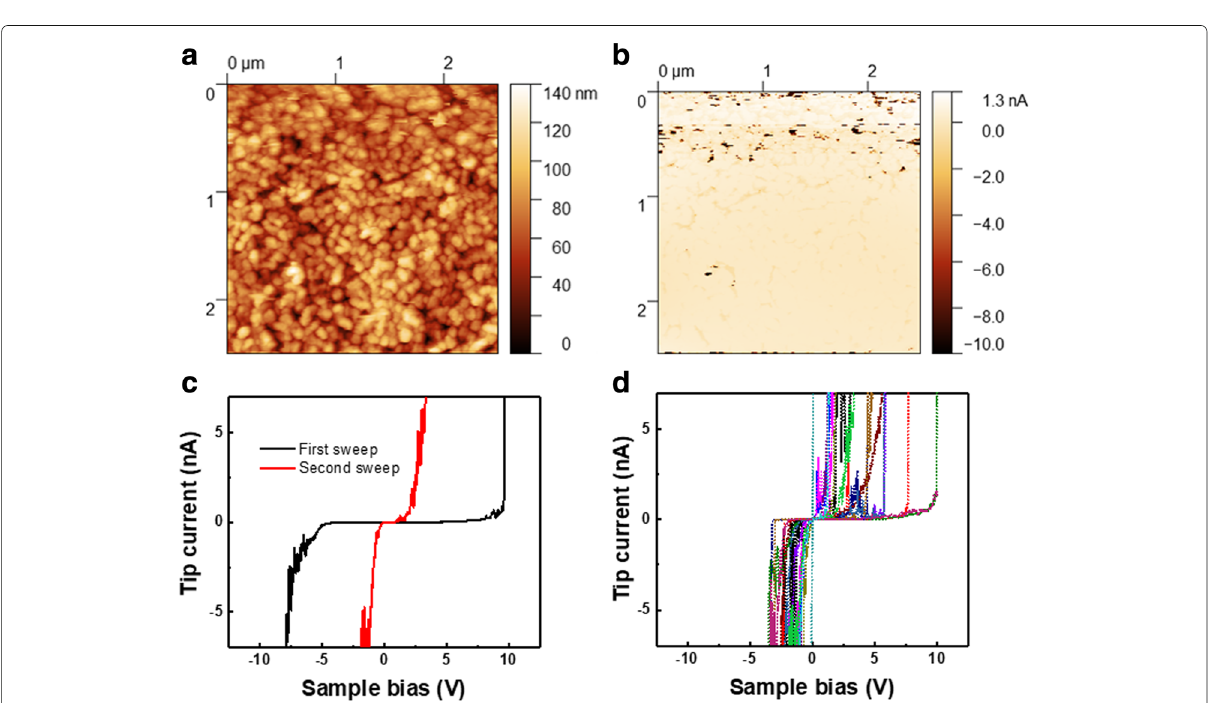
Fig. 5 a C-AFM mapping of the nanowires topology. b Corresponding tip current, with -8V bias applied to the sample. c I-V curve of a single nanowire with sample voltage bias from -10 V to 10 V, showing different I-V characteristic between initial and second sweep. d Distribution of I-V curve from a number of nanowires, after the initial punch-through